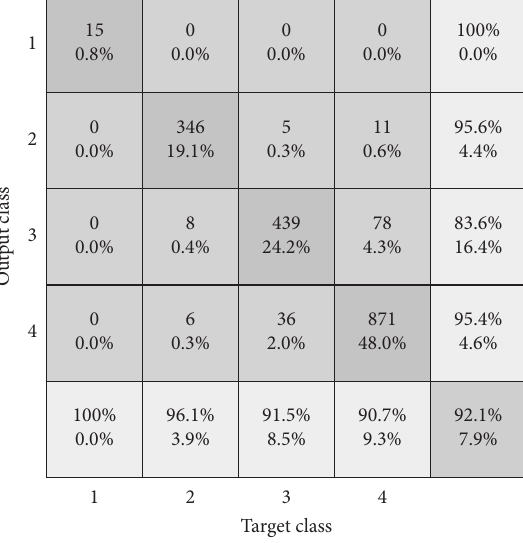
Figure 9: Output accuracy of the ANN classifier.